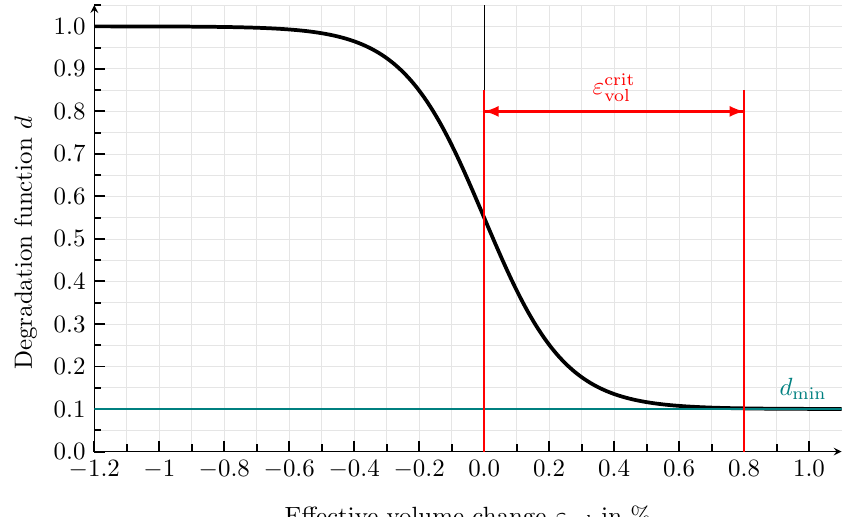
Figure 8. Degradation function of the graphite stiffness. Threshold value of the volume change, ε crit minimum value of the degradation function, d min .